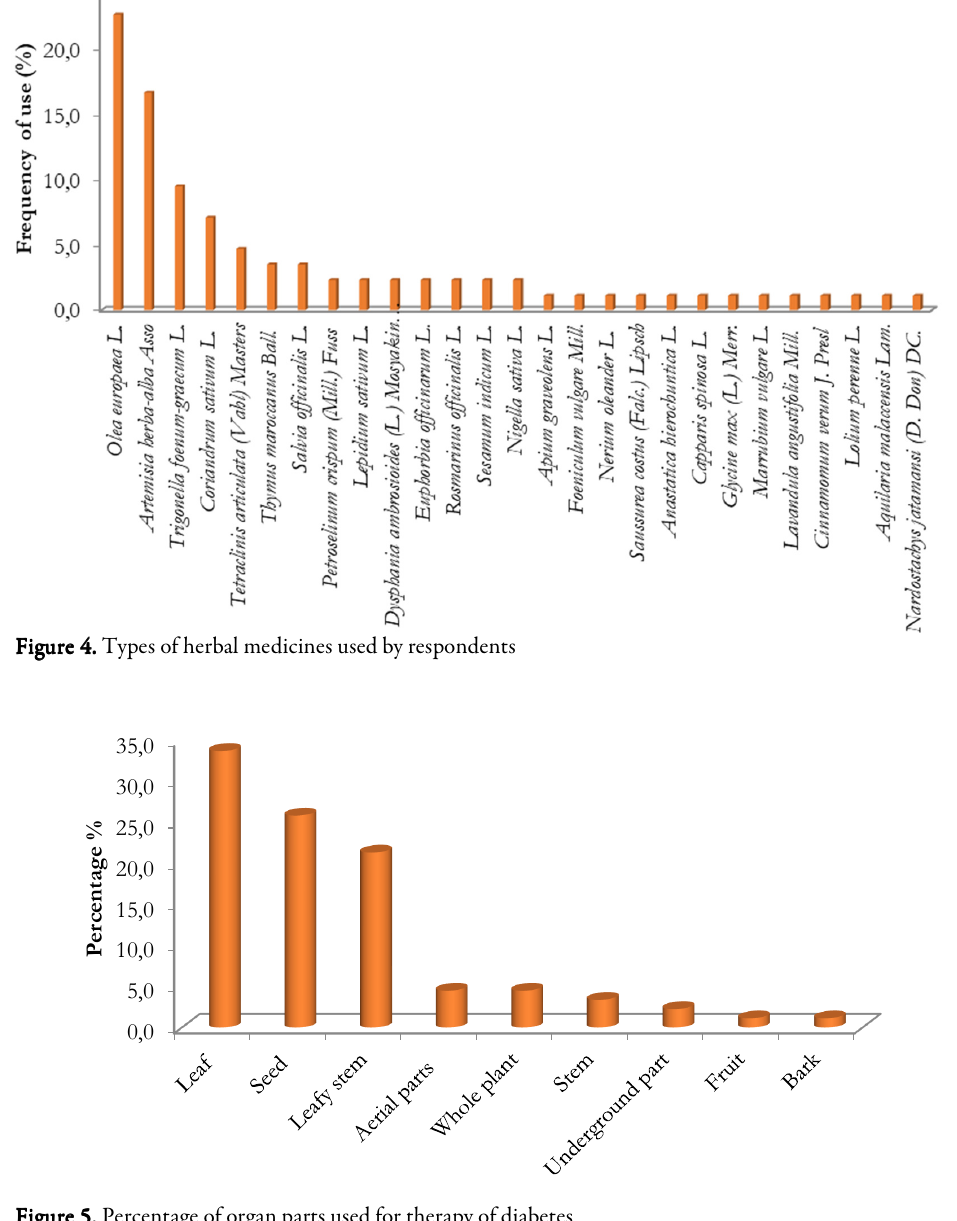
Figure 5. Percentage of organ parts used for therapy of diabetes